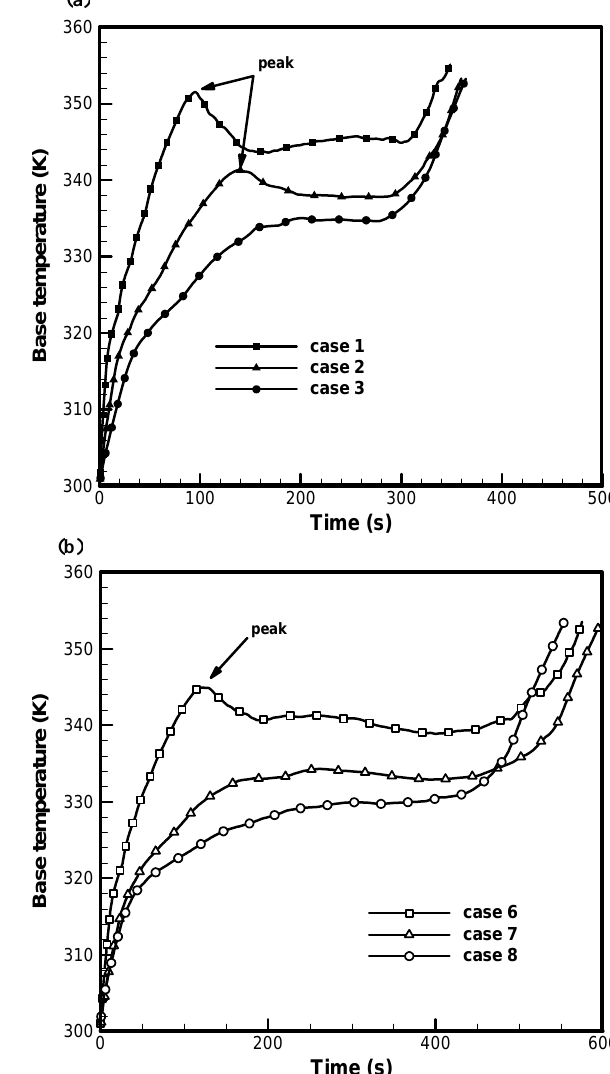
Figure 6. Melt fraction evolution with time for different fin thick- nesses: (a) various cases for fin height of 15mm and (b) various cases for fin height of 25mm.